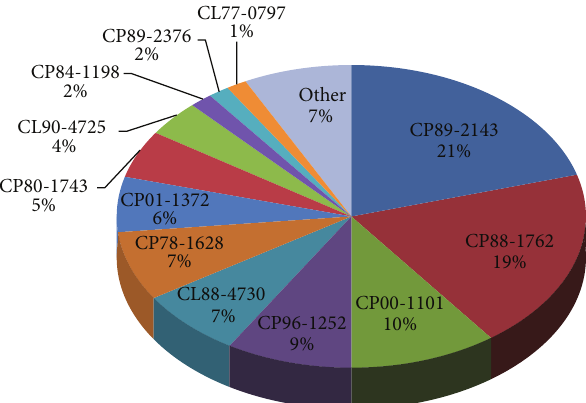
Figure 4: Commercial sugarcane cultivars and their % of total hectarage in the 2012-2013 harvest season in Florida. Total area = 172,118 ha. Data are adopted from Rice et al.